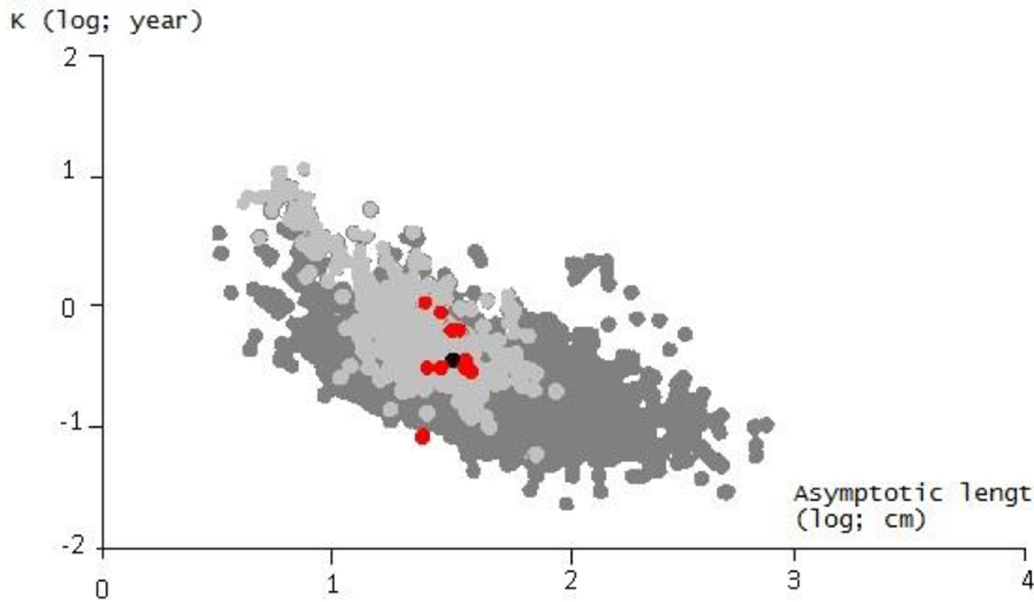
Fig 6. Auximetric plot for Sardinella maderensis in Senegalese waters using the data from Table 2. Dots represent the growth performance index ( φ ') fitted against Log 10 (K) on the y-axis and Log 10 (L 1 ) on the x-axis. Light grey dots represent fish species in the same family ( Clupeidae ) while dark grey dots are other species. Red dots represent values for Sardinella maderensis from the literature and the black dot represents the value from this study.